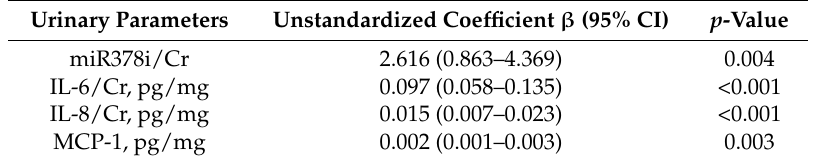
Figure 6. Urinary miR-378i is positively correlated with SASP and renal dysfunction in type 2 DM patients. ( A ) Urinary miR-378i levels were higher in type 2 DM patients ( n = 107) compared to healthy individuals ( n = 45). Urinary SASP levels, including interleukin-6 (IL-6) ( B ), IL-8 ( C ), and monocyte chemoattractant protein-1 (MCP-1) ( D ), were higher in type 2 DM patients than in healthy individuals. Urinary miR-378i levels were positively correlated with SASP, including IL-6 ( E ), IL-8 ( F ), and MCP-1 ( G ), in the urine of humans. Urinary miR-378i levels ( H ), IL-6 ( I ), IL-8 ( J ), and MCP-1 ( K ) were positively correlated with log-formed urinary albumin/creatinine ratio (ACR) in human participants. Human participants with macroalbuminuria had higher urinary miR-378i levels ( L ), IL-6 ( M ), IL-8 ( N ), and MCP-1 ( O ), than those with normoalbuminuria. Urinary miR-378i levels ( P ), IL-6 ( Q ), IL-8 ( R ), and MCP-1 ( S ) were negatively correlated with estimated glomerular filtration rate (eGFR) in human participants. Exosomal miR-378i in the urine of humans was isolated, then assessed by quantitative real-time PCR normalized to a reference control. Magnetic Luminex ® Assay was used to assess urinary IL-6, IL-8, and MCP-1. Urine albumin was measured using immunoturbidimetric assay and urine creatinine was determined by an enzymatic method. Normoalbuminuria is defined as urinary ACR <30 mg/g; microalbuminuria is defined as urinary ACR ≥ 30 mg/g and <300 mg/g; macroalbuminuria is defined as urinary ACR ≥ 300 mg/g. The bar graph represents the mean ± S.E.M. * p < 0.05, ** p < 0.01, *** p < 0.001 by Student t test or ANOVA, followed by the post hoc test adjusted with a Tukey correction, and p -value of correlation was analyzed by Spearman analysis. The unit of Cr as mg/dL. The unit of IL-6 and MCP-1 as pg/mL. Cr: creatinine. The unit of eGFR as mL/min/1.73m 2 . Table 6. Determinants of albuminuria using multivariate linear analysis in human